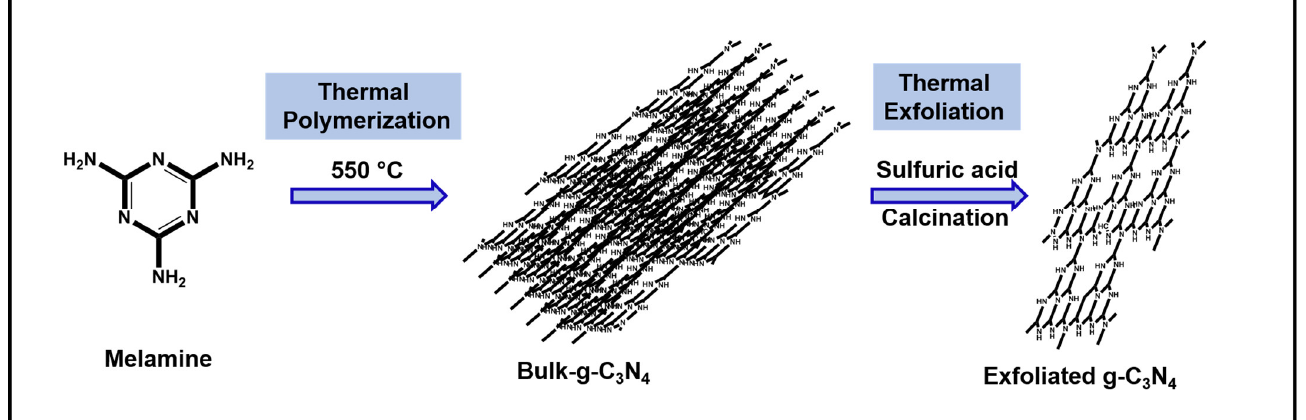
Figure 1. Simplified representation of the production of exfoliated g -C 3 N 4.